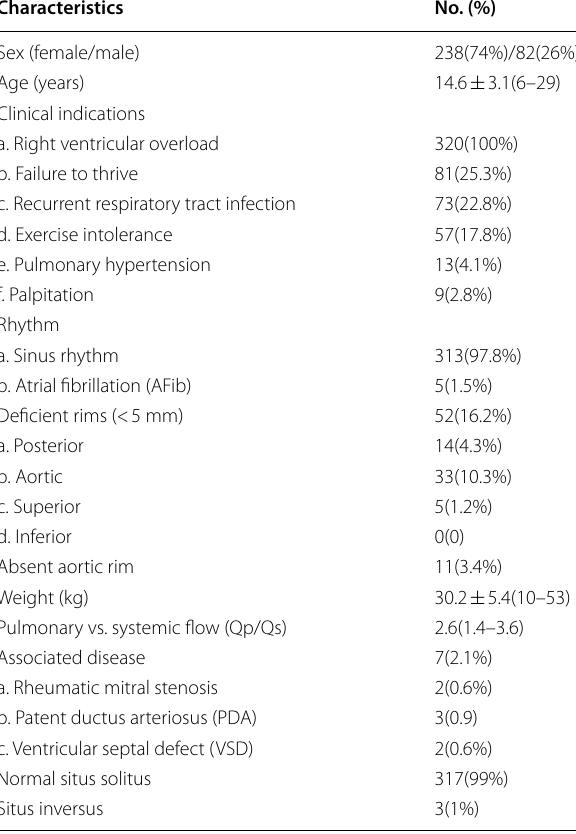
Table 1 Baseline demographic and clinical presentation of